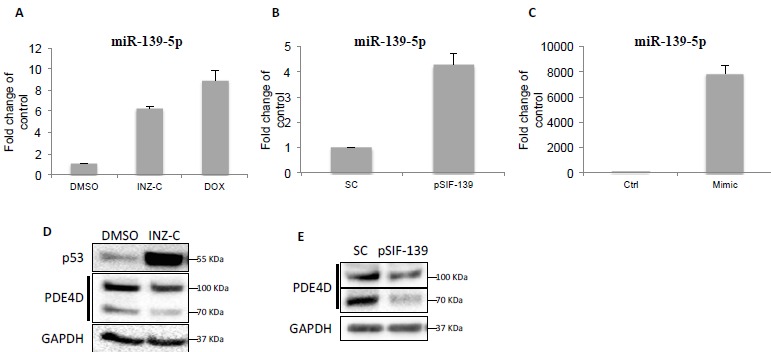
Downregulation of PDE4D by p53 and miR-139-5p.(A) H460 cells were treated with DMSO, 2 μM INZ-C or 0.5 μM Dox for 18 hr followed by qRT-PCR analysis of miR-139-5p. (B) and (C) H460 cells were transfected with pSIF-H1-Scramble control (SC) or pSIF-H1-miR-139-5p (pSIF-139) (B), or negative control oligos (Ctrl) or miR-139-5p mimic (Mimic), followed by qRT-PCR analysis of miR-139-5p at 48 hr after transfection. Samples from (A) and (B) were also analyzed by Western blot as shown in (D) and (E), respectively.